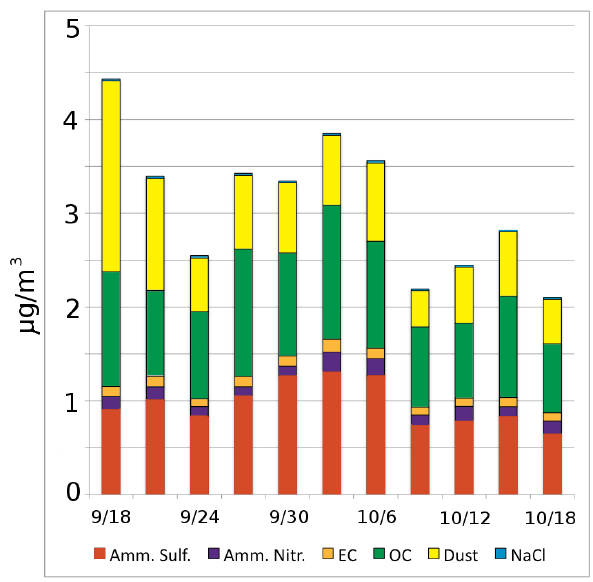
Fig. 2. PM 2 . 5 composition as measured by the IMPROVE program at the MEVE1 site and averaged over the ten year period, 1999– 2008. EC = elemental carbon; OC = organic